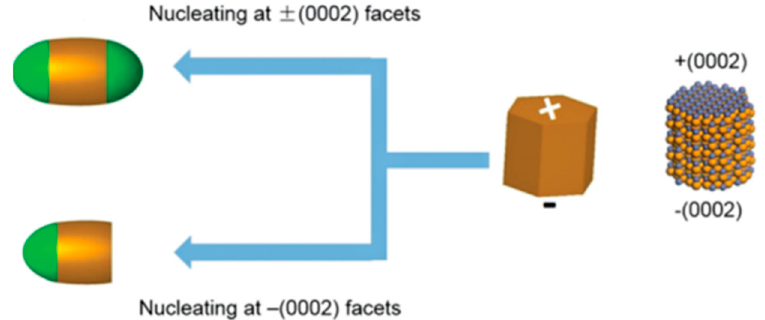
Figure 9. Scheme of the dot-in-rod heterostructure growth with different morphology. Reproduced with permission from [139]. Copyright RSC, 2014.